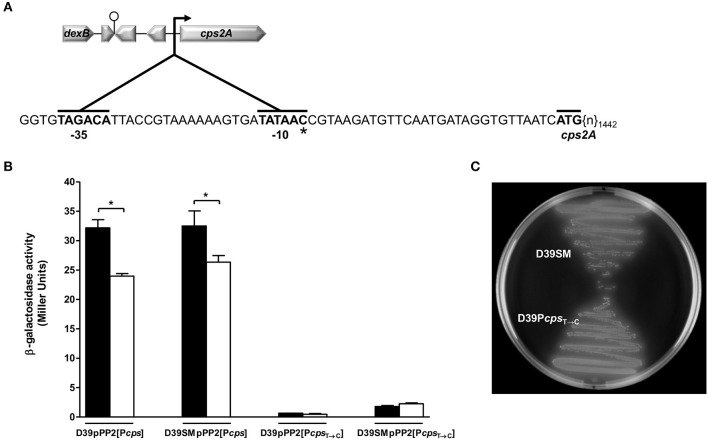
Expression of Pcps and PcpsT→C in D39 and D39SM. (A) Schematic overview of the dexB-cps2A region and magnification of the cps promoter area of D39SM. Hooked arrow, cps promoter; lollipop, putative terminator; zoomed area (inset), promoter region of the cps gene cluster; −35 and −10 binding box, and the starting codon of the cps2A gene are indicated in bold; the number of bp of the cps2A gene next to the starting codon is subscripted after {n}; *, point mutation (T→C) in −10 binding box of D39SM strain. (B) Transcription of cps and cpsT→C promoters was estimated by measuring β-galactosidase activities in exponentially growing D39 and D39SM strains, carrying the pPP2 integrative lacZ reporter plasmid, in Glc-CDM (black bars) and Glc-CDM depleted of uracil (white bars). β-galactosidase activities are expressed as Miller units. (C) Colony phenotype of D39SM and D39PcpsT→C strains in Glc-M17 blood agar plates. All the determinations were done in duplicate in two independent experiments and the values represented are means ± SD. *p-value < 0.05.